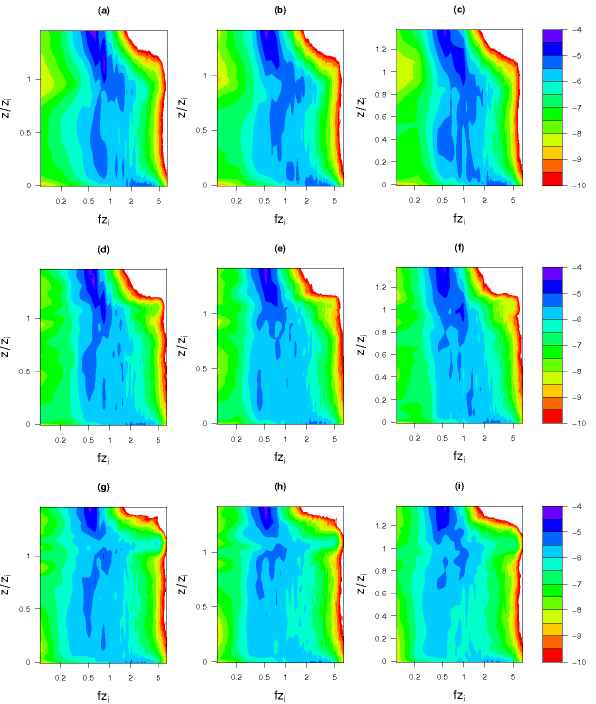
Fig. 9. Normalized spectra [P m] for the low wind speed scenario as a function of length scale increasing from left to right (a–c) vertical velocity (d–f) air temperature and (g–i) specific humidity.